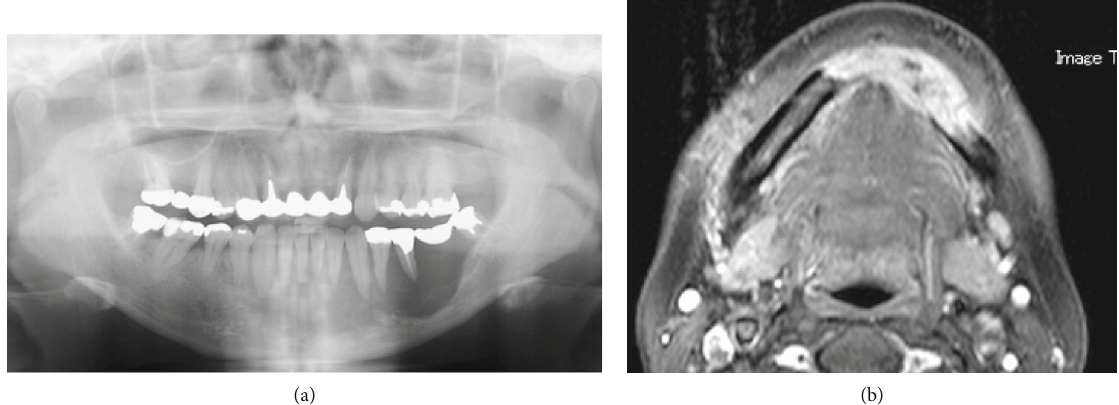
Figure 1: (a) Panoramic radiograph revealing a posterior well-demarcated radiolucent area and anterior irregular area. (b) Magnetic resonance images (T1 weighted) showing a tumor in the midline to the left side of the mandible with a high-signal mass measuring 42 × 13